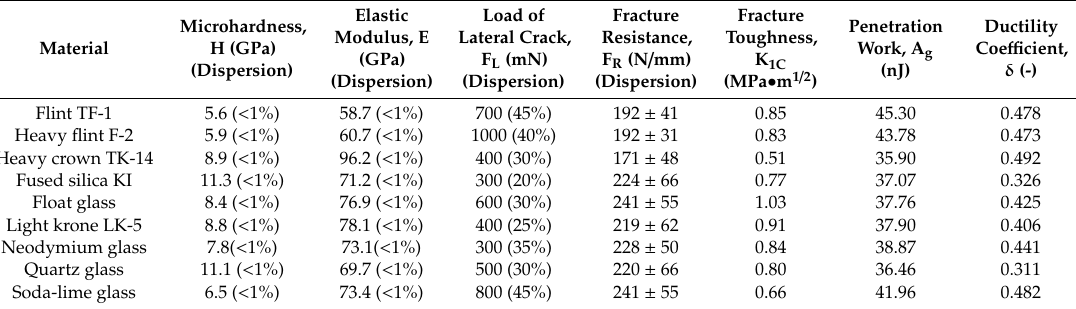
Table 1. Mechanical properties of the studied glasses.